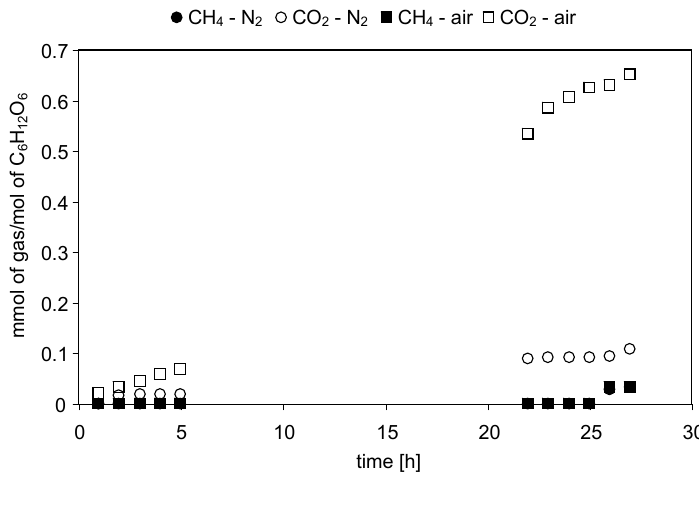
Figure 4. Evolution of CH 4 and CO 2 in time of irradiation during the photocatalytic degradation of C 6 H 12 O 6 . Photocatalyst loading: 1 g/dm 3 ; C 6 H 12 O 6 concentration: 1 mol/dm 3 ; solution pH: 5.4; t = 25